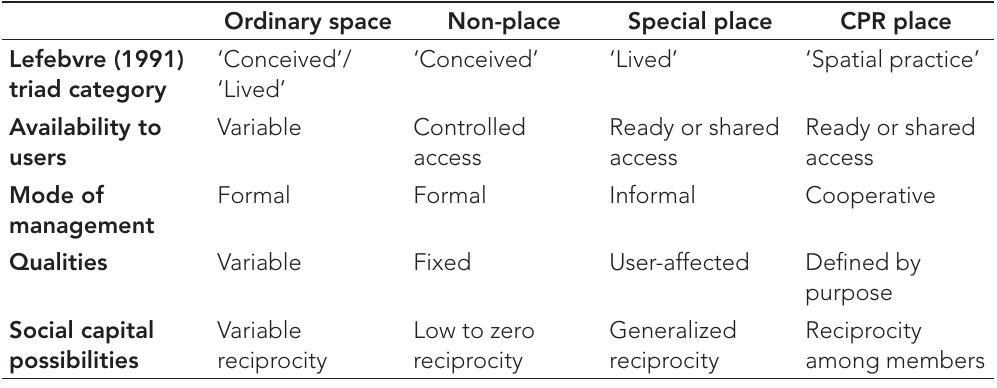
Table 1: Characteristics of types of